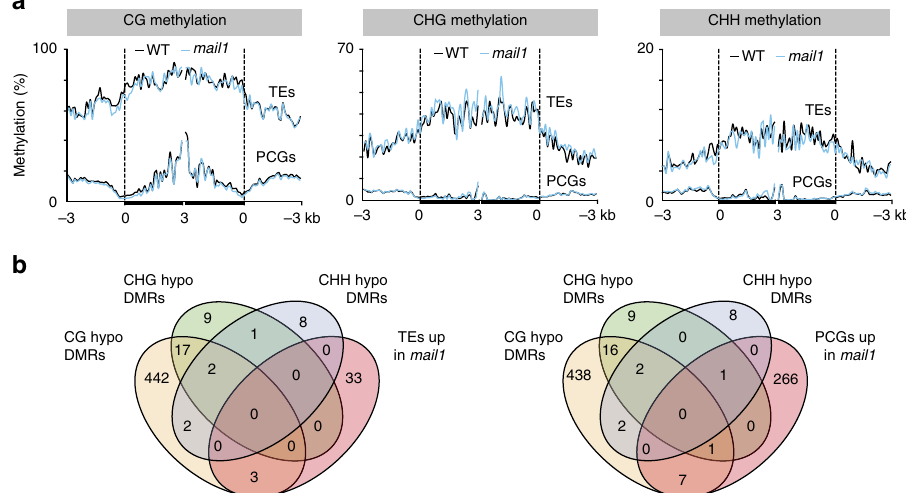
Figure 3 | DNA methylation is not impaired in mail1. ( a ) PCGs or TEs significantly upregulated in mail1 were aligned at the 5 0 -end (left dashed line) or the 3 0 -end (right dashed line), and average methylation levels in CG, CHG and CHH sequence contexts for each 100-bp bin in WTand mail1 were plotted from 3kb upstream to 3kb downstream. ( b ) Venn diagrams of overlap between genomic regions differentially hypomethylated in mail1 (hypo DMRs) in the three cytosine sequence contexts and TEs and PCGs significantly upregulated in mail1